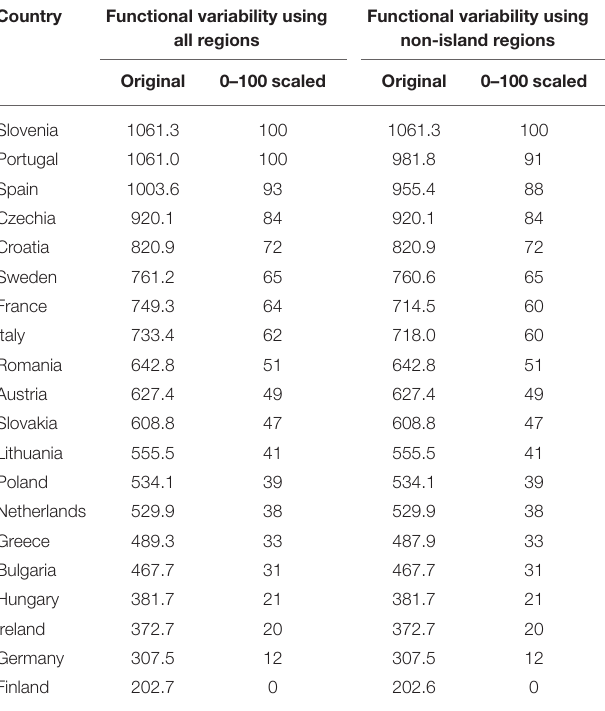
TABLE 3 | Functional variability of each country, weighted by the population of the regions, using the L 2 metric. Country Functional variability using all